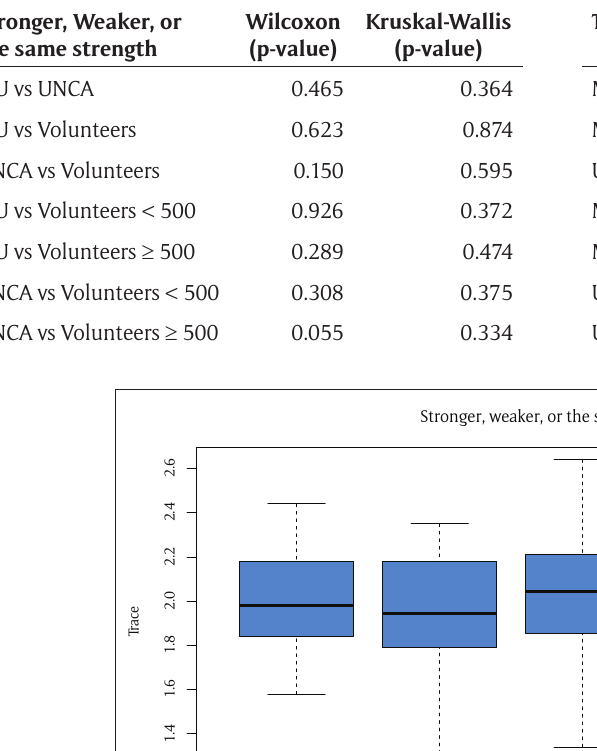
Table 4: Wilcoxon and Kruskal Wallis test results for Stronger, Weaker, or the same strength. No cases are sig- nificant at the 95% level, although UNCA versus volun- teers > 500 comes very close.